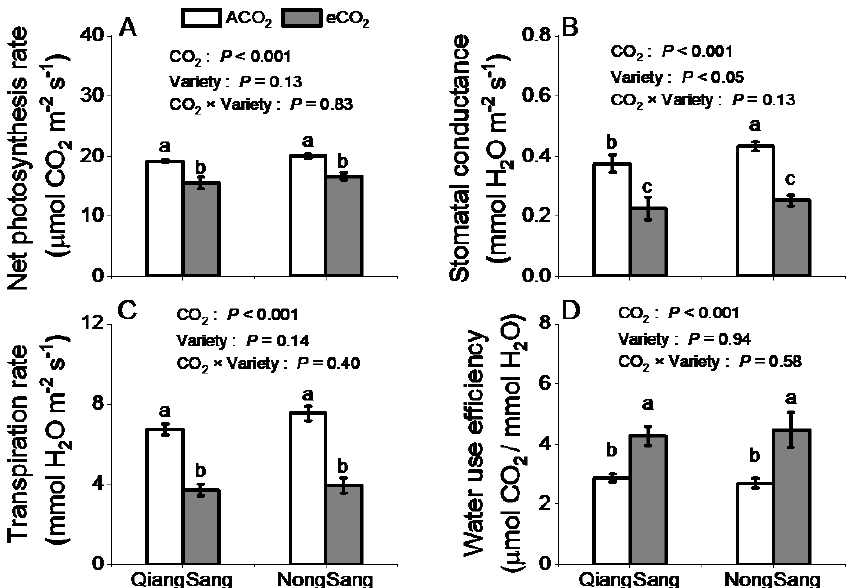
Figure 1. Gas exchange characteristics of two mulberry varieties ( Morus multicaulis Perr. var. QiangSang and NongSang) grown under ambient CO 2 (ACO 2 , 410/460 ppm, daytime/nighttime) and elevated CO 2 (eCO 2 , 710/760 ppm) levels: ( A ) net photosynthetic rate; ( B ) stomatal conductance; ( C ) transpiration rate; and ( D ) water use efficiency. Data (means ± SE, n = 3) followed by different letters indicate significant differences ( p < 0.05) as revealed by Tukey’s test. Statistical comparisons (two-way ANOVA) between varieties and CO 2 treatments as well as their interaction (CO 2 × variety) are presented for each variable.